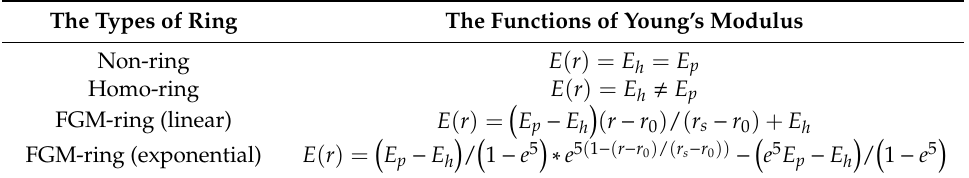
Table 2. Four types of the reinforcing ring with di ff erent functions of Young’s modulus. The Types of